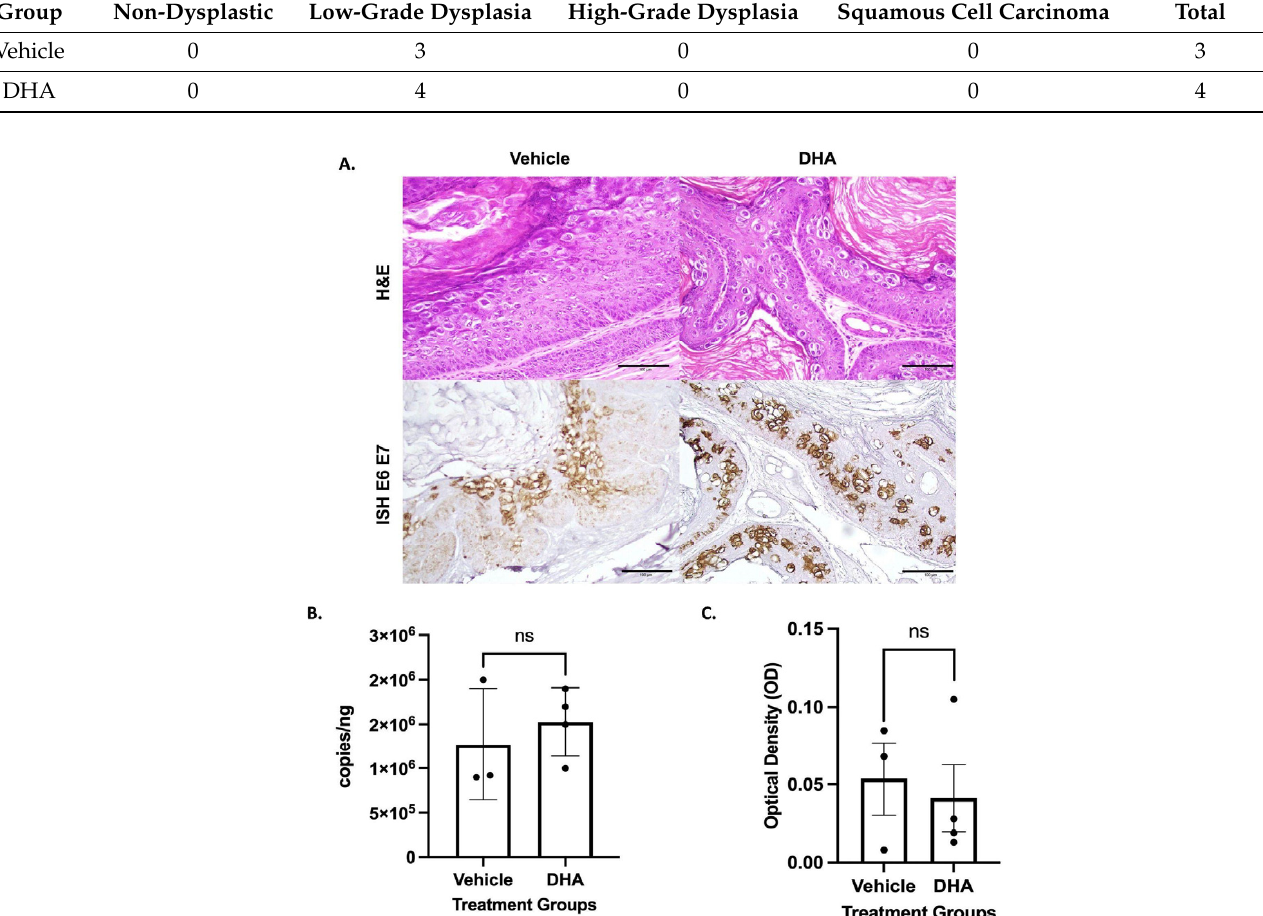
Figure 3. NSG mice infected with MmuPV1 in the cervicovaginal canal began treatment ~26.5